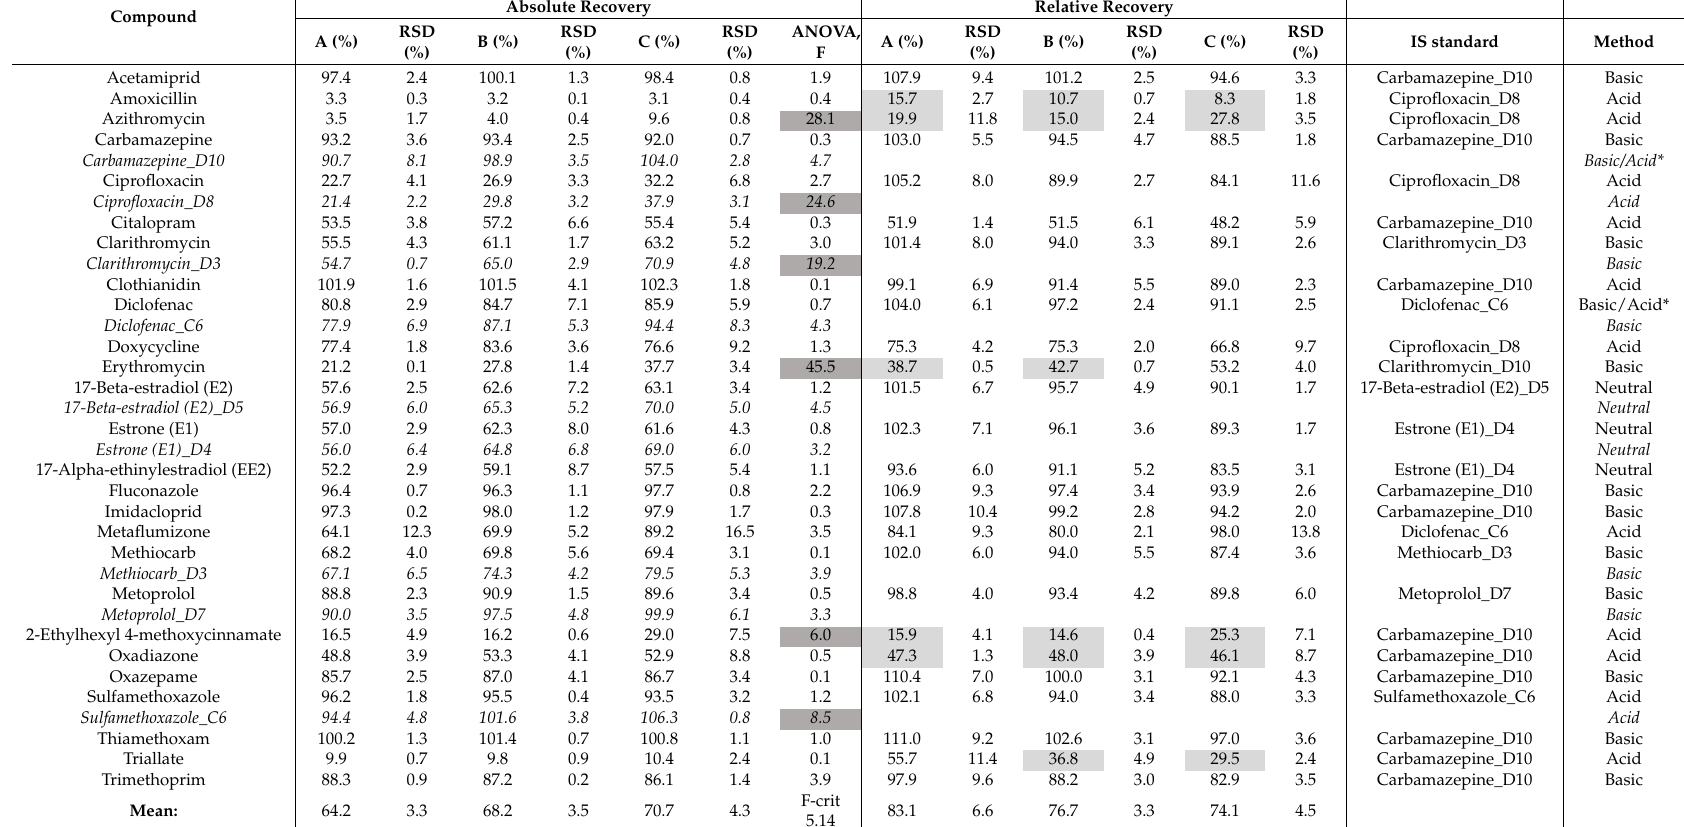
Table 1. Absolute and relative recoveries of 26 compounds and 9 isotope labeled standards (IS) spiked in 0.5 liter pure water at a high concentration level applying three different flow rates; A = 10 mL/min, B = 20 mL/min, and C = 40 mL/min. Each experiment (A, B, and C) ran as triplicate. One-way ANOVA was performed on the absolute recovery results at p = 0.05, F crit = 5.1. Absolute recovery for 6 compounds (grey marked) exceeded F crit = 5.1. Compounds showing relative recovery lower than 50% are marked in light grey. The absolute amounts added ranged from 10–1000 ng depending on the compound (see Table 2, high, column 10). *Compound is run in both acid and basic UPLC (Ultra-Performance Liquid Chromatography) method. The 9 IS are indicated in